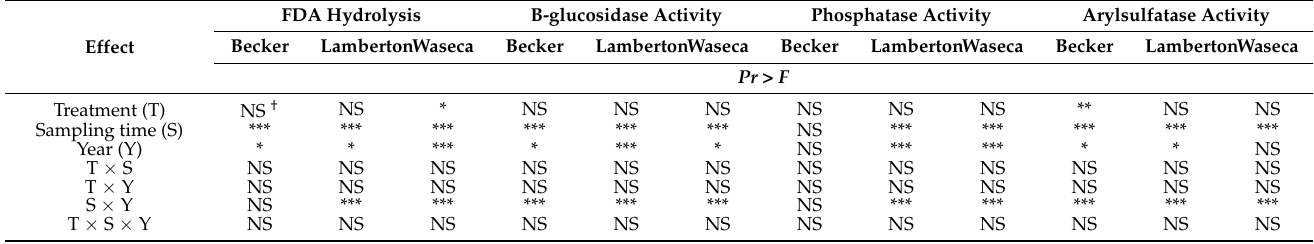
Table 2. Tests of fixed effects of N fertilizer rate and timing of application on FDA hydrolysis, β - glucosidase activity, phosphatase activity, and arylsulfatase activity from at Becker, Lamberton, and Waseca, MN.